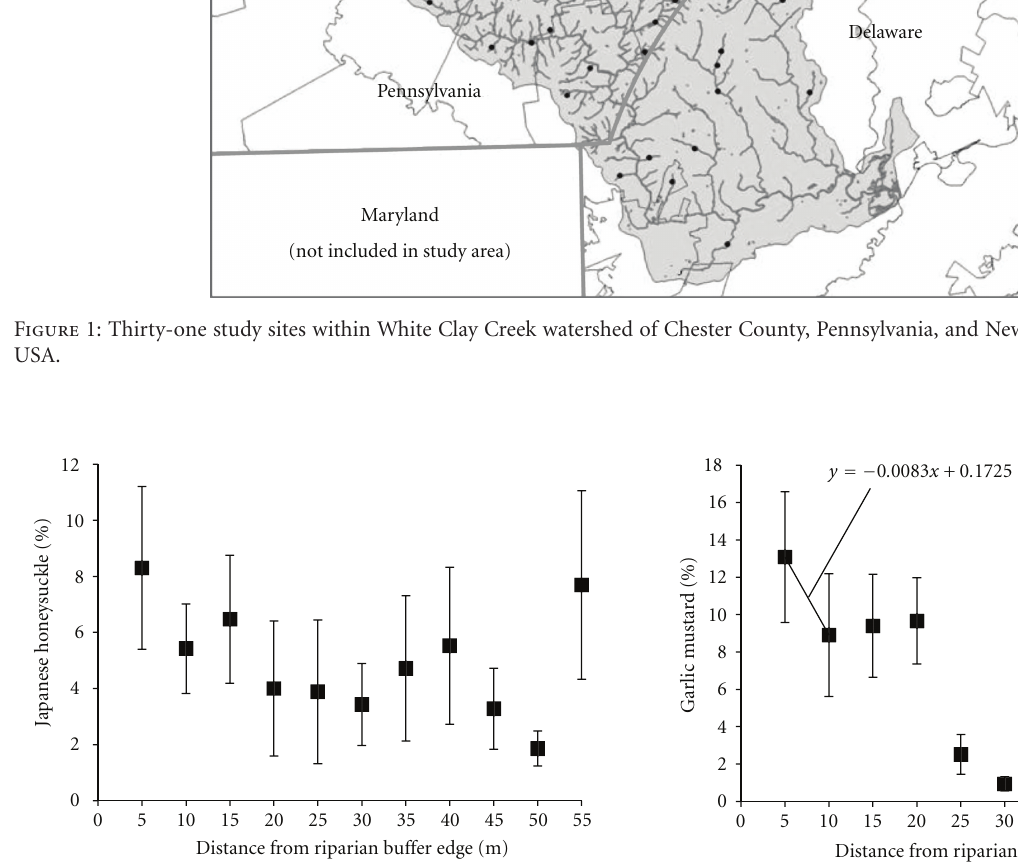
Figure 2: The prevalence of Japanese honeysuckle away from the edge of forested riparian bu ff ers in Delaware and Pennsylvania, 2007-2008.